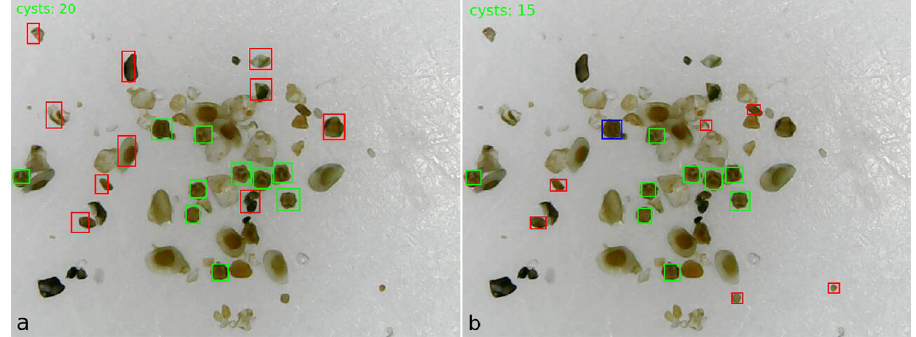
Fig 9. Example of detecting and counting cysts of the Faster R-CNN (a) and YOLOv3 (b) architectures, both with batch size set at 2. Green boxes are true positives with score detection � 0.3, red boxes are false positives, and blue boxes are false negatives.